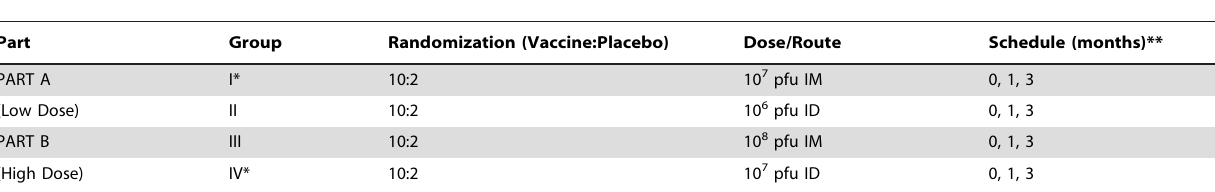
Table 1. RV158 Study